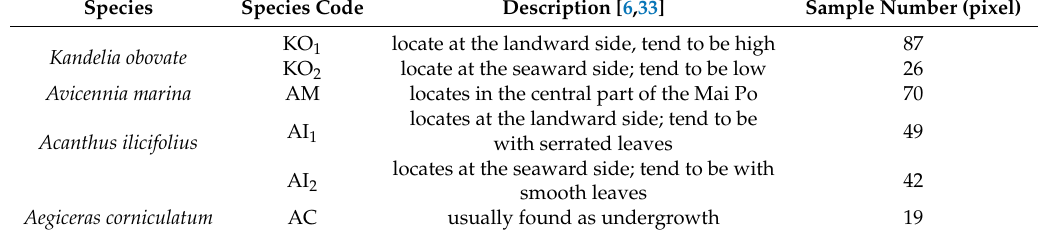
Table 3. The description and sample number of six mangrove species collected in MPNR.